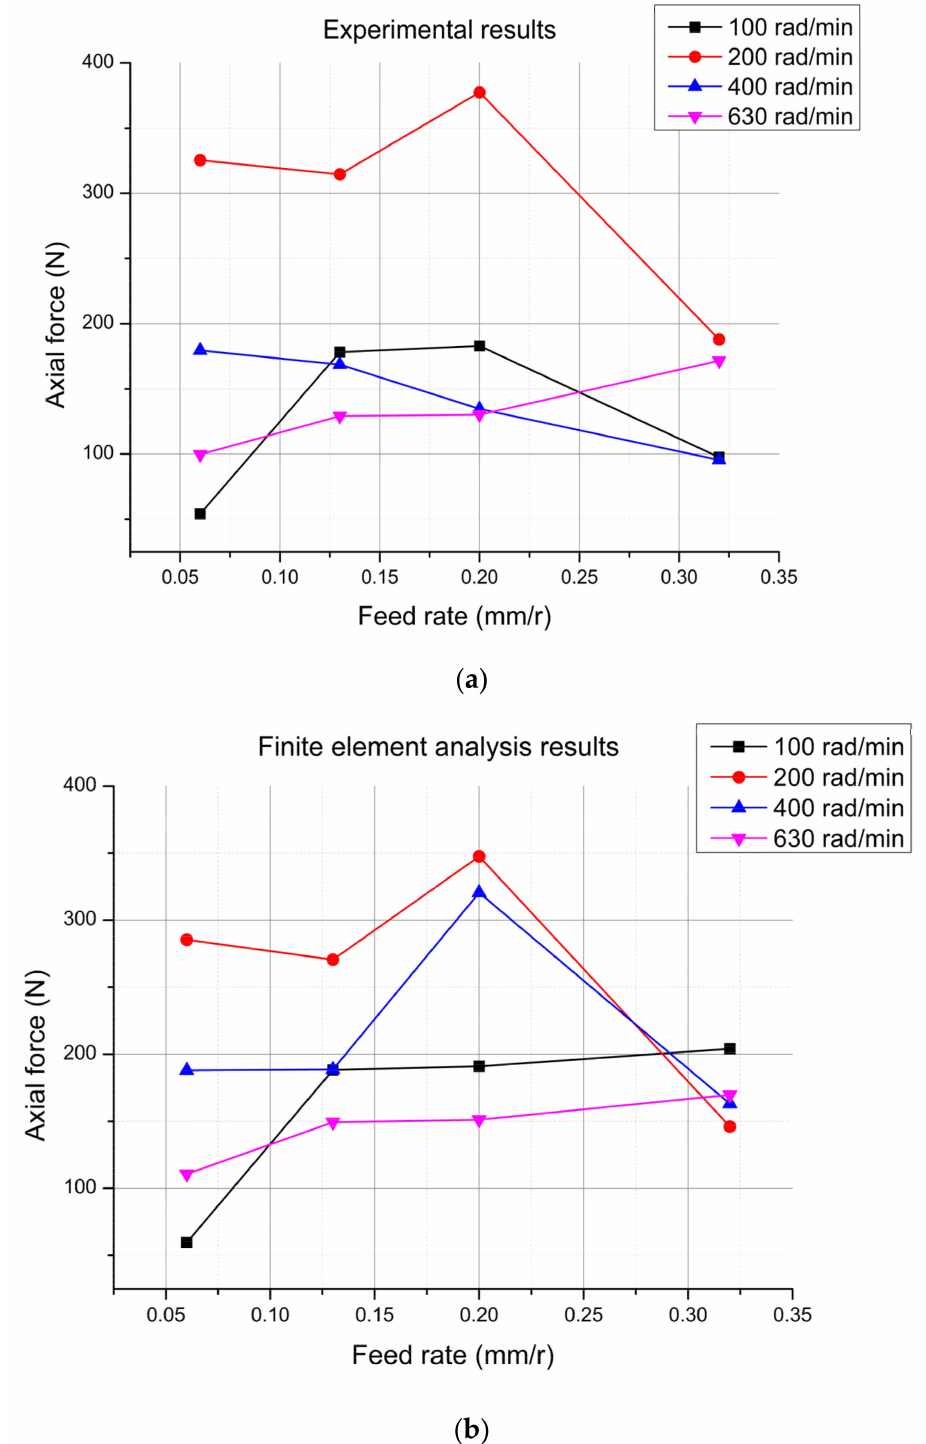
Figure 10. Experimental data 2 for granite. ( a ) During the test, the axial force changed as the feed rate changed at different rotational speeds. ( b ) Finite element analysis results corresponding to the test